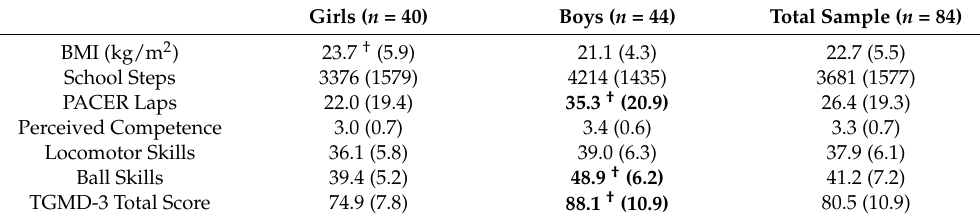
Table 1. Descriptive statistics (means and standard deviations).